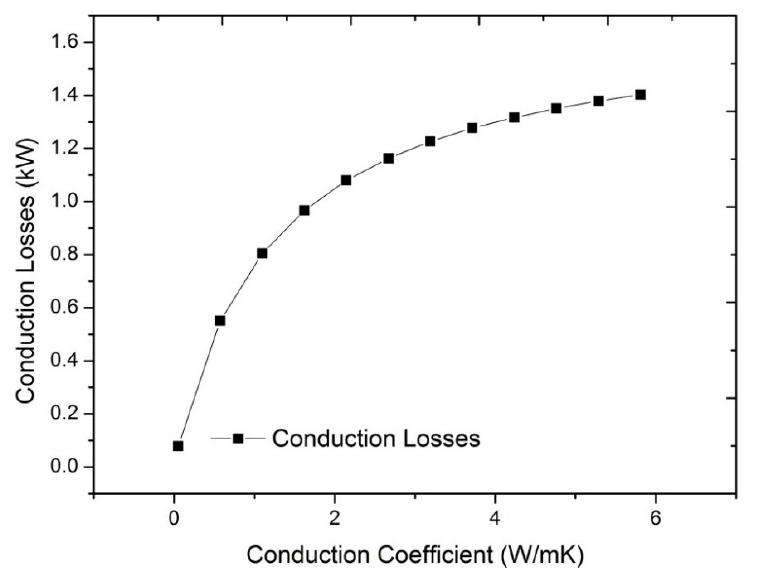
Figure 15. Conduction losses varying conduction coefficient (solar source: 28